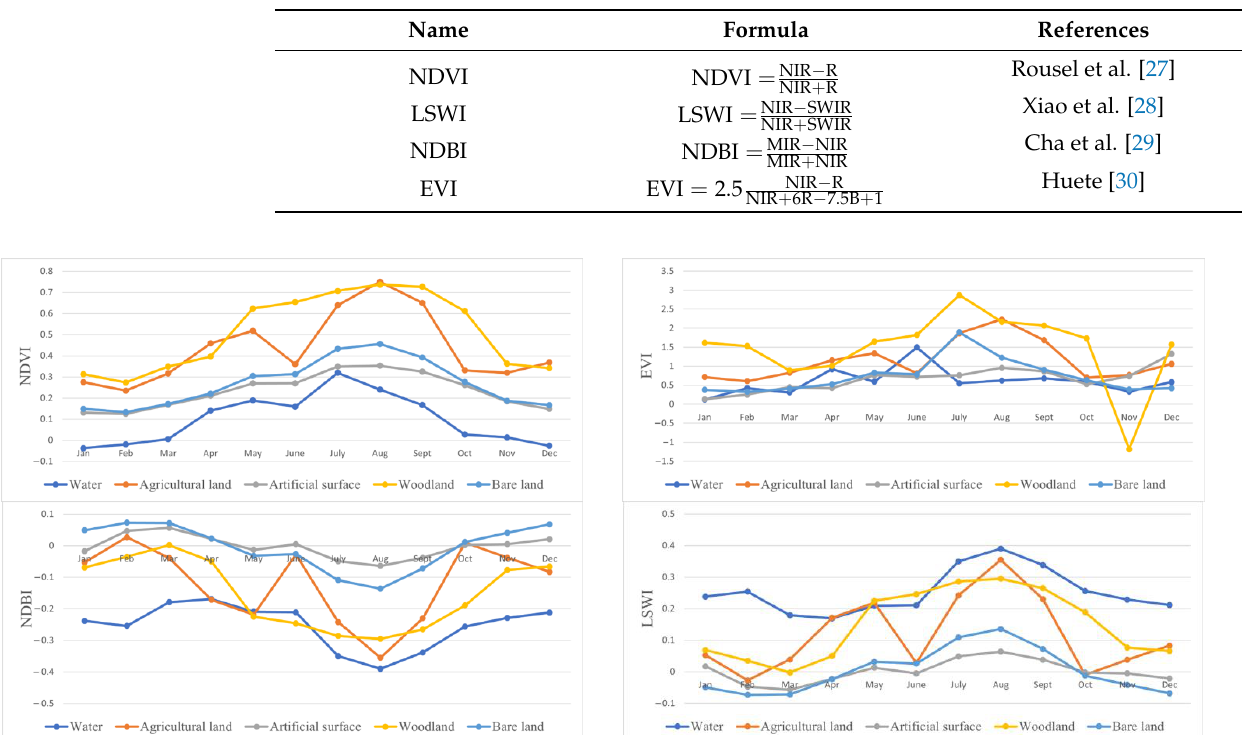
Table 1. The vegetation indices computed in this study from Landsat 8.